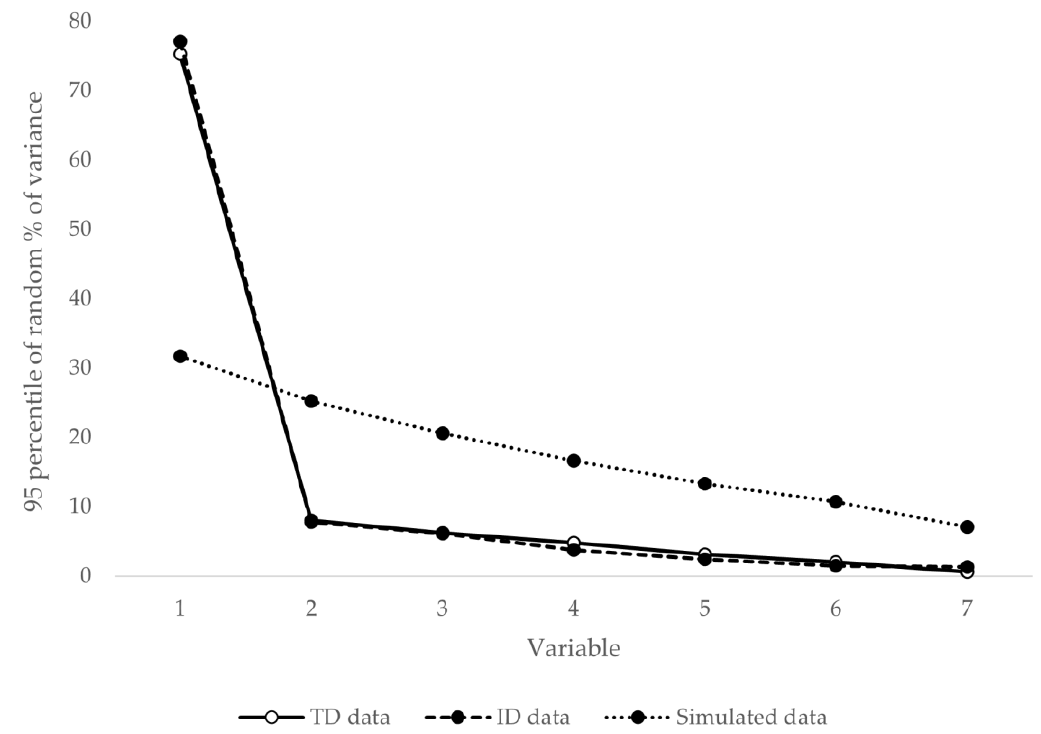
Figure 1. Results of the parallel analysis. Note: TD = typical development; ID = intellectual disability group; variable = number of common factors. Table 1. Differential item functioning analysis of oppositional defiant disorder (ODD)